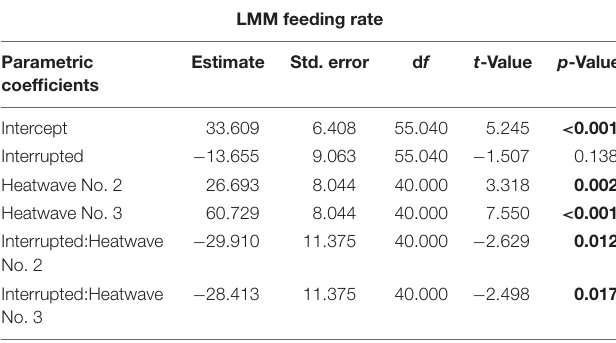
TABLE 4 | Linear Mixed-effect Model results for feeding rate (mg mussel dry weight per day) over the three heatwave events in the Interrupted heatwave